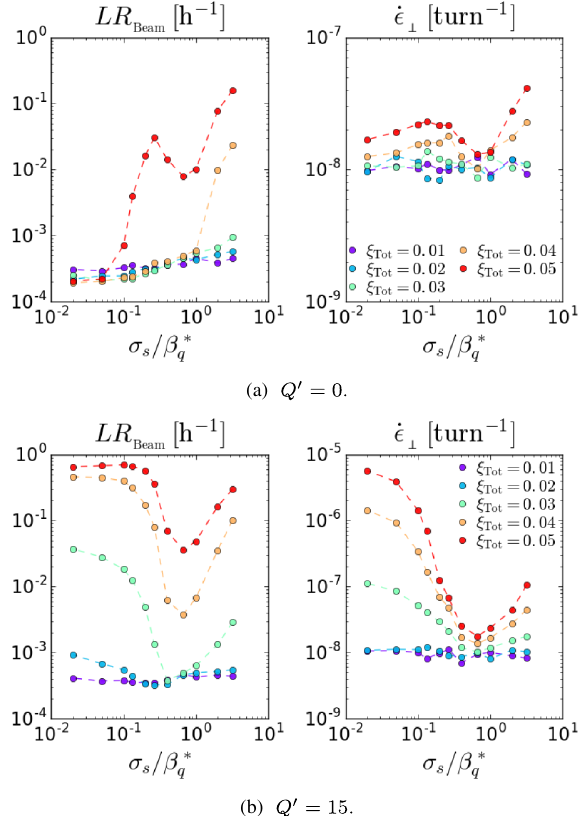
FIG. 18. Beam quality reduction for different combinations of ξ β (cid:1) , when Q x ¼ 0 . 31 , Q y ¼ 0 . 32 , and ϕ q and Tot